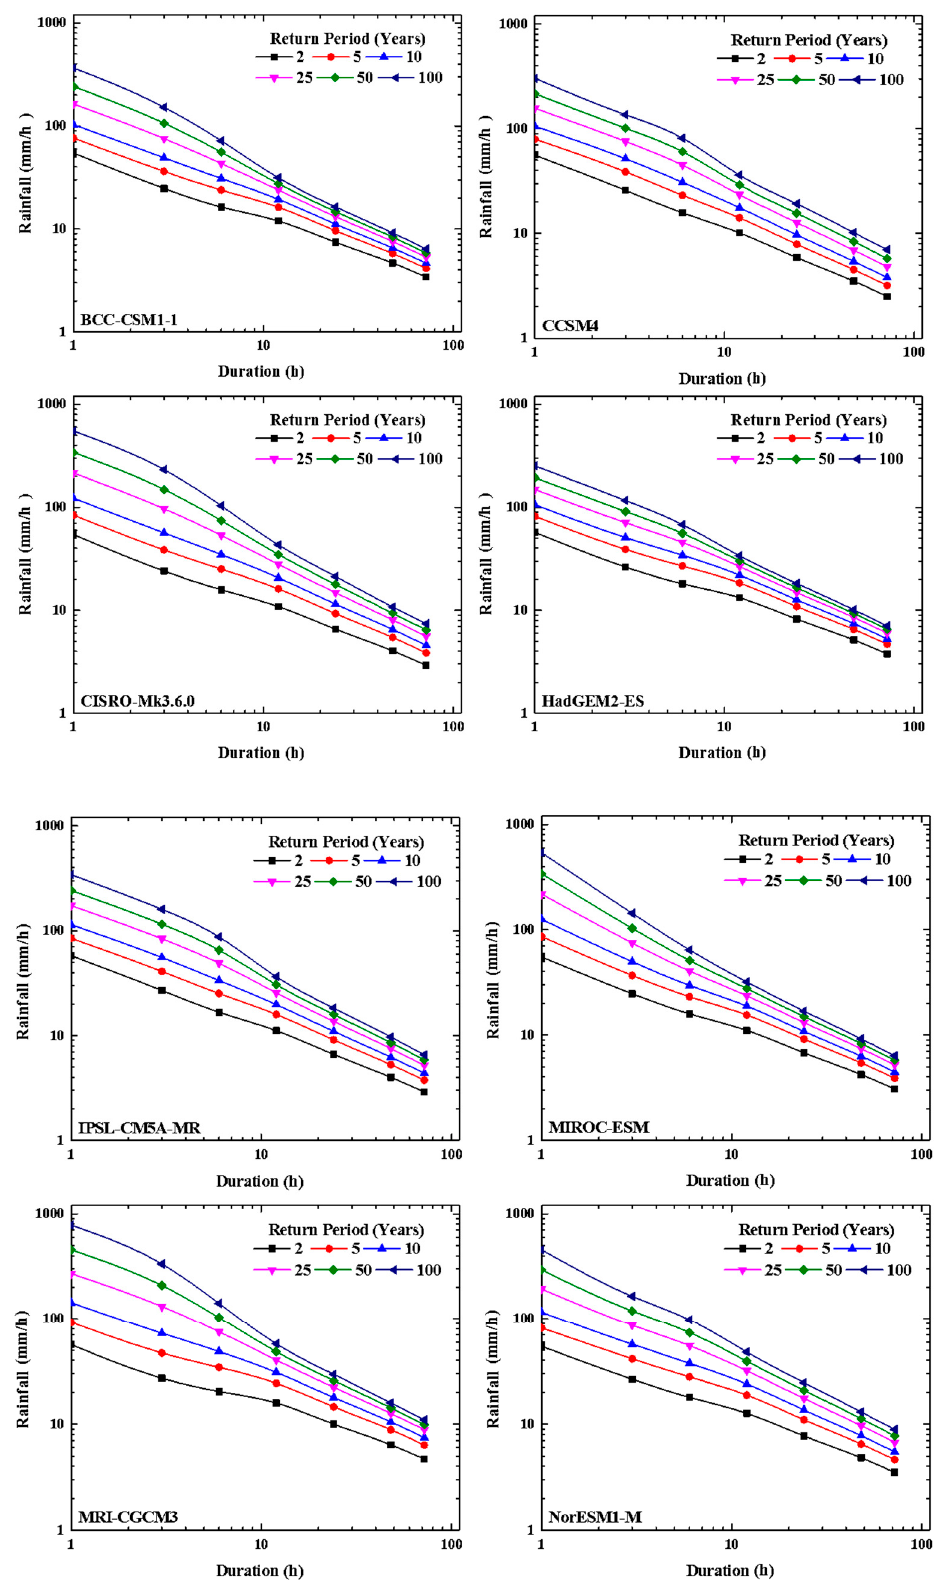
Figure 6. The IDF curves developed for station Kedah using GCMs simulated historical rainfall data (1971–2005).